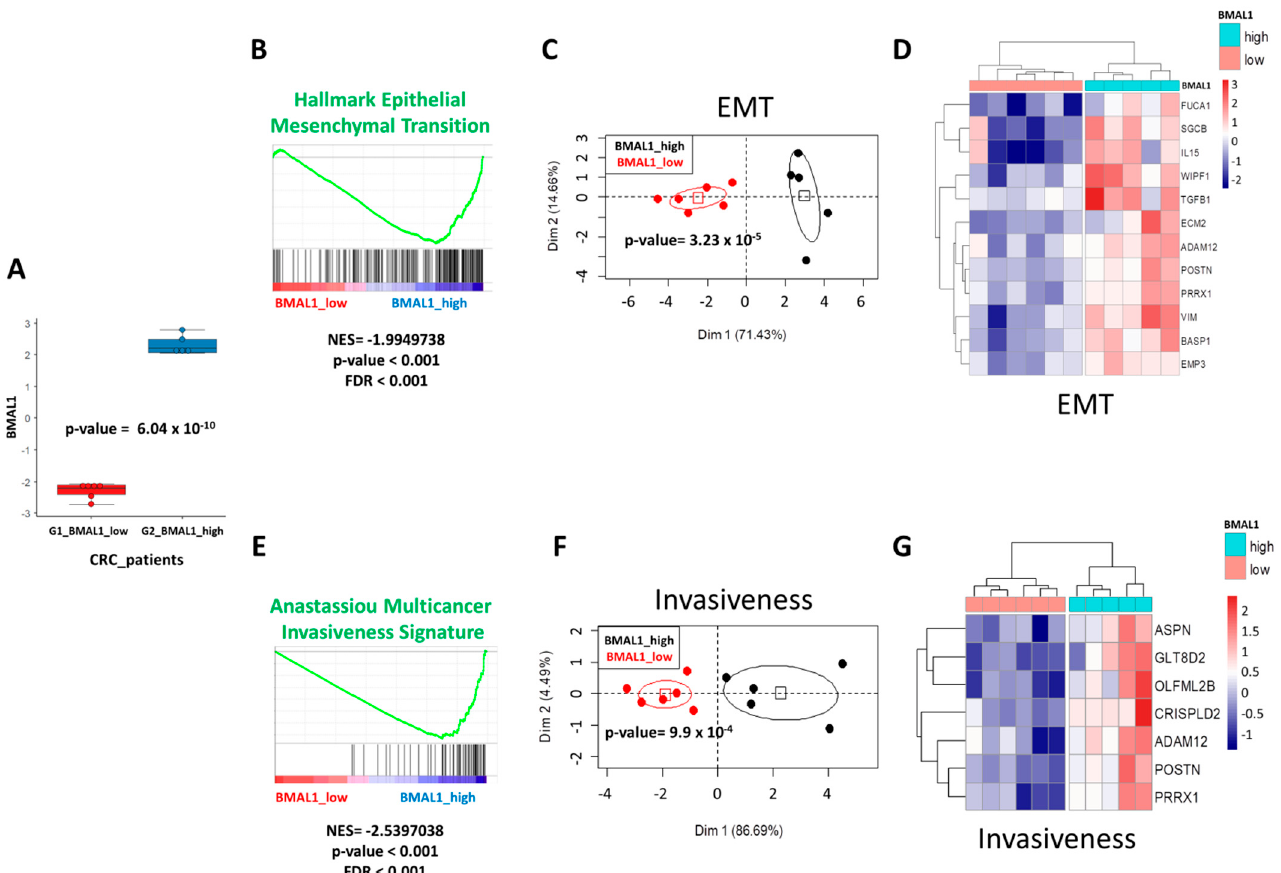
Figure 1. BMAL1 deregulation in colorectal carcinomas (CRC) is associated to epithelial–mesenchymal transition (EMT) and cancer invasiveness perturbations. ( A ) Boxplot of mRNA expression (Z-scores, RNAseq) in tumors of CRC with patients stratified on their BMAL1 quantification. ( B ) Enrichment for hallmark EMT gene sets in CRC tumors of patients with a high level of BMAL1 (NES: Normalized Enrichment Score). ( C ) Principal component analysis performed with EMT-enriched genes found deregulated in CRC tumor samples. ( D ) Expression heatmap of EMT genes connected to BMAL1 in CRC tumors. ( E ) Enrichment of multicancer invasiveness signature in CRC tumors of patients with a high level of BMAL1 (NES: Normalized Enrichment Score). ( F ) Principal component analysis performed with cancer invasiveness-enriched genes found deregulated in CRC tumor samples. ( G ) Expression heatmap of cancer invasiveness genes connected to BMAL1 in CRC tumors.